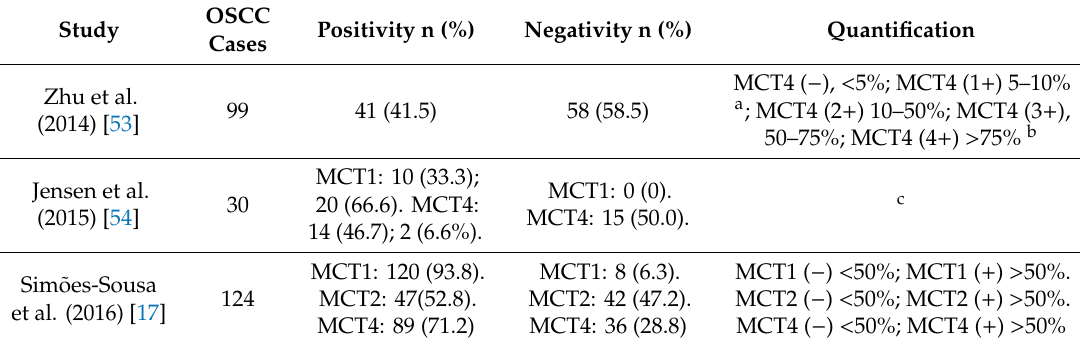
Table 2. MCT immunohistochemical expression in oral squamous cell